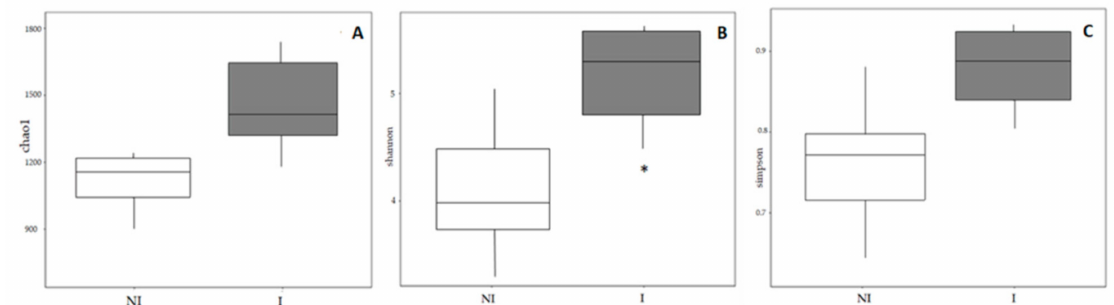
Figure 7. Alpha diversity metrics in the skin mucus of European sea bass. ( A ) Chao1 index (chao1), ( B ) Shannon–Wiener index (Shannon), ( C ) inverse-Simpson index (Simpson) in the mucus microbiota of non-infected (NI) and infected (I) European sea bass. Different indices are represented by Box-Whisker diagrams for the two experimental groups. Significant differences are indicated with an